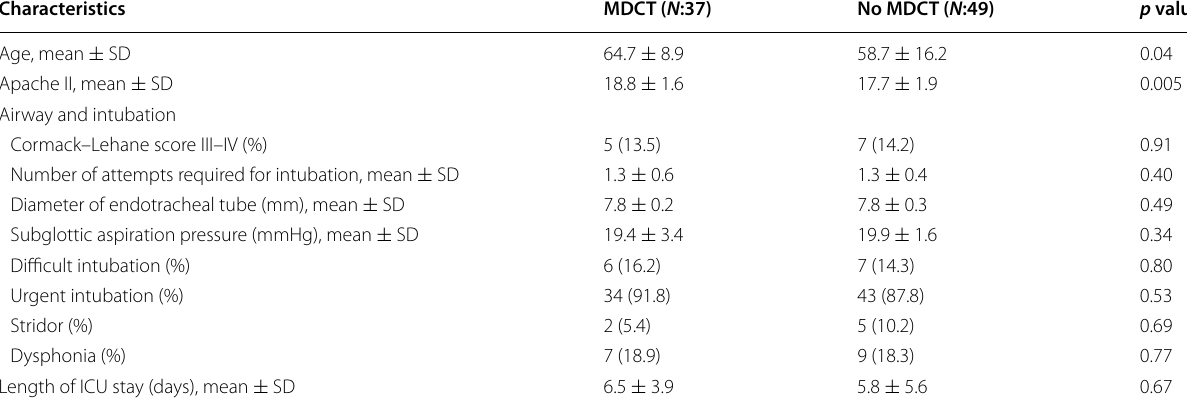
MDCT multidetector computed